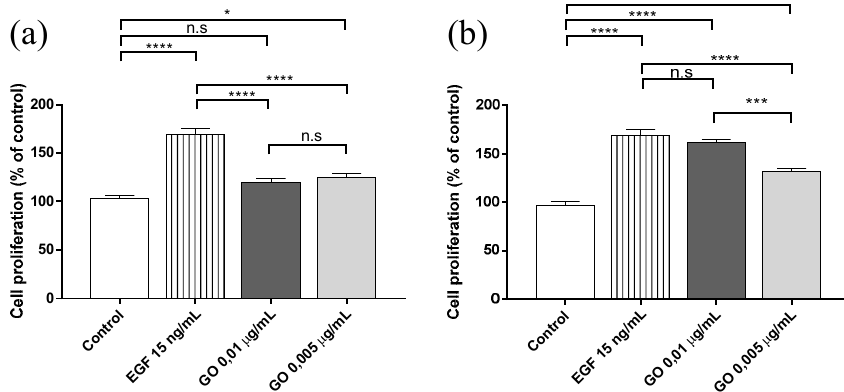
Figure 2. Proliferation in human keratinocytes stimulated by exposure to GO for 72 ( a ) and 96 ( b ) h. Data are presented as the mean ± standard error of the mean (SEM) of six replicates. The ANOVA results of the different graphene oxide (GO) concentrations and epidermal growth factor (EGF) are indicated in the plot with respect to control. * p > 0.05; *** p > 0.01; **** p > 0.001; n.s: not significant.